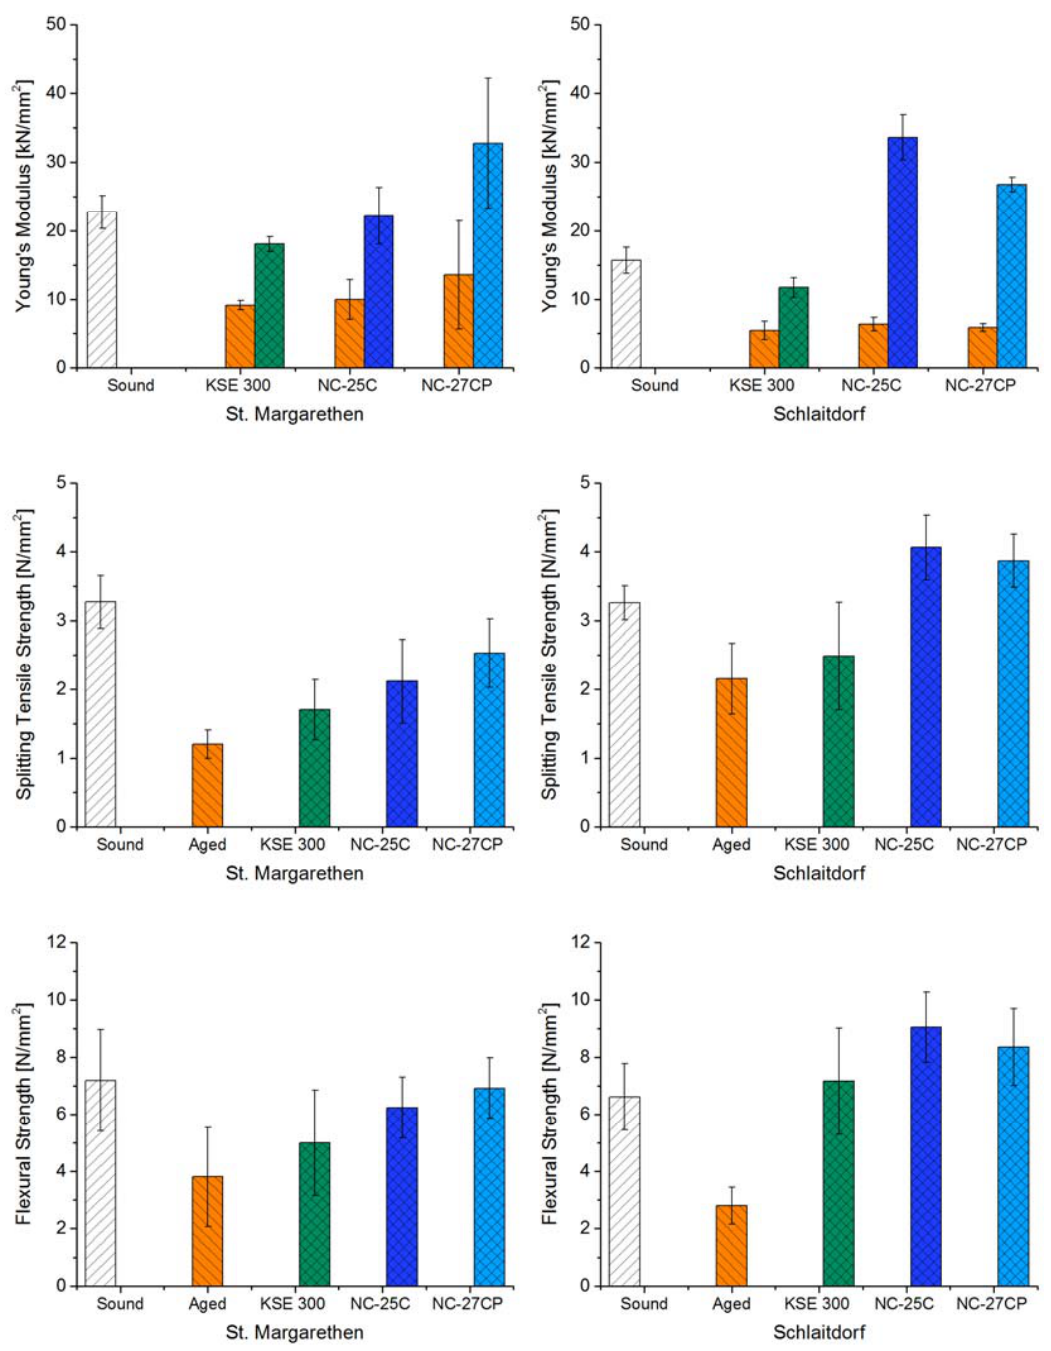
Figure 6. Illustration of Young’s modulus [kN/mm 2 ], splitting tensile strength [N/mm 2 ], and flexural strength under concentrated load [N/mm 2 ] for St. Margarethen Limestone ( left side ) and for Schlaitdorf Sandstone ( right side ). All tests performed six months after consolidation. Please note that the dynamic modulus of elasticity was performed on the same specimens before and after treatment. Bars with orange filling represent aged samples before consolidation. Table 3. Rounded values for relative decrease/increase [%] for sound (S), aged (A) and consolidated (C) samples and absolute average values of Young’s modulus [kN/mm 2 ], splitting tensile strength [N/mm 2 ], and flexural strength under concentrated load [N/mm 2 ] for St. Margarethen Limestone and Schlaitdorf Sandstone . The graphical visualisation of the same values can be found in Figure 6. All tests were performed six months after consolidation.